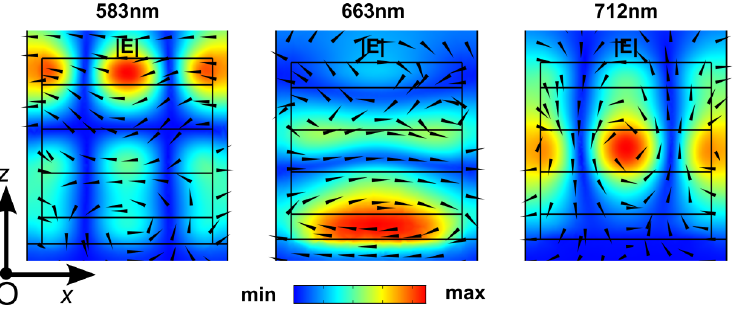
Figure 4. 2D color maps ( xOz plane) of electric field norm (| E |) distribution for resonances in meta- material without a spacer (Figure 3 (iii)). The arrows denote corresponding magnetic field